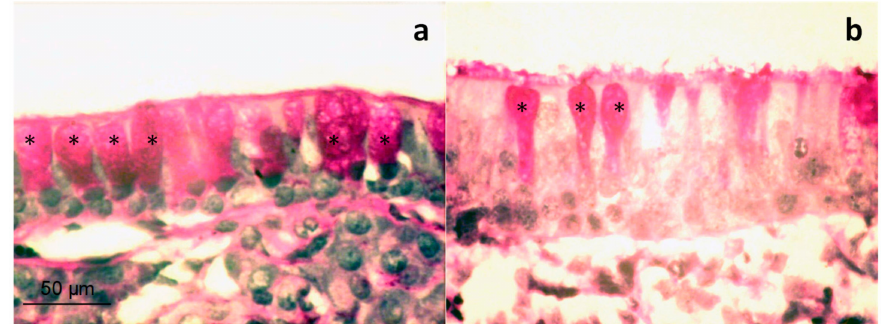
Figure 5. Histology of nasal mucosa (respiratory region) of rabbits treated with freeze-dried Cyclamen saponins at therapeutic dose. Di ff erent sections shown in panel ( a ) and panel ( b ) are stained with PAS. Asterisks indicate goblet cells full of secretory material. Scale bar = 50 µ m.